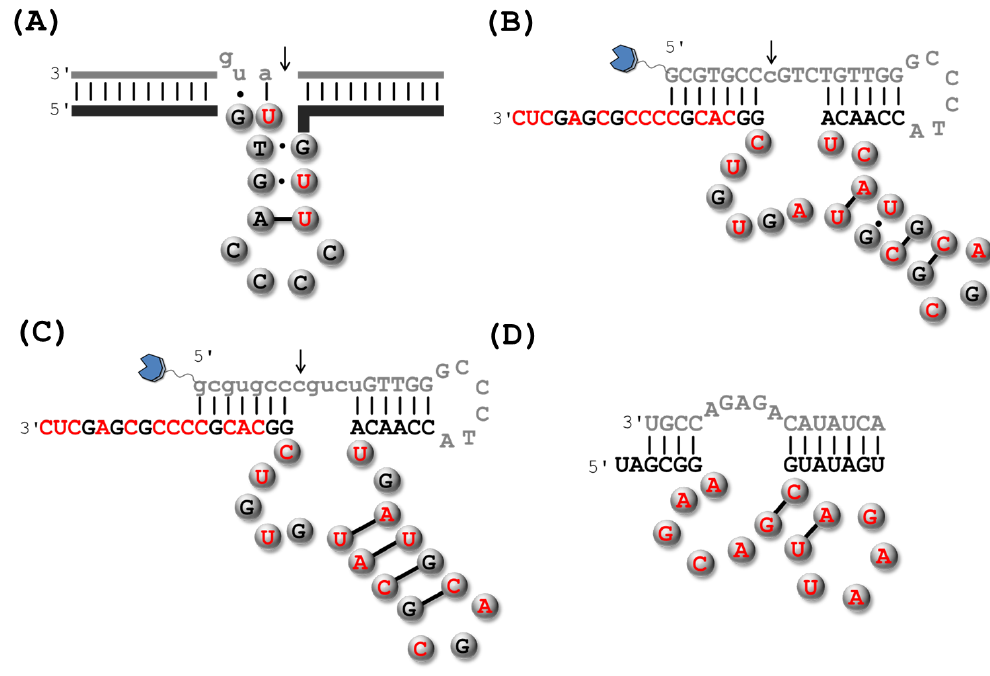
Figure 11. Sequences and hypothetical 2D structures of DNAzymes obtained with dN*TPs included in the in vitro selections: Dz16.2-11 ( A ), Dz9-86 ( B ), Dz12-91 ( C ), and FANAzyme FR17_6 ( D ). The bold red letters highlight the position of the modifications while arrows indicate the cleavage sites.